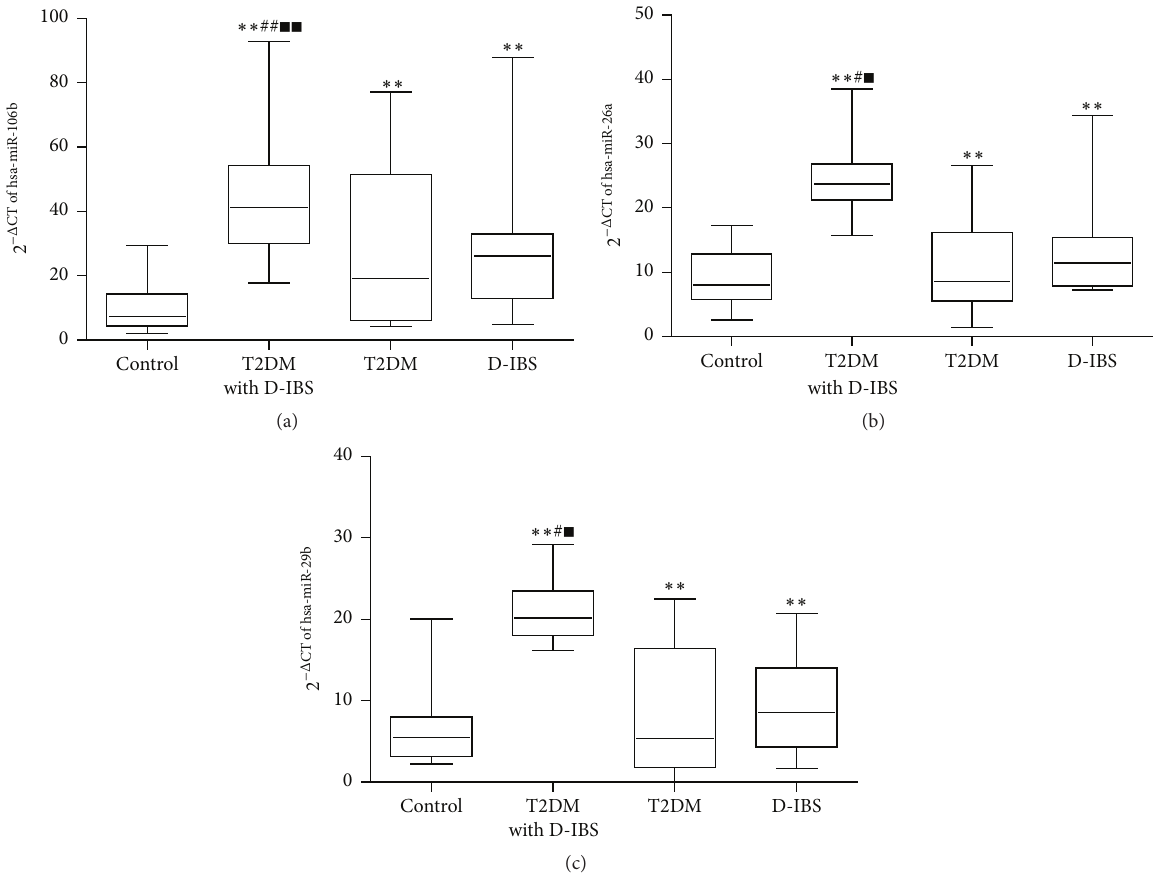
Figure 2: Box plots showing the differential expression of (a) hsa-miR-106b, (b) hsa-miR-26a, and (c) hsa-miR-29b in healthy controls and in patients with T2DM, D-IBS, and T2DM with D-IBS. ∗∗ 𝑝 < 0.01 versus control; ## 𝑝 < 0.01 and # 𝑝 < 0.05 versus T2DM; ◼◼ 𝑝 < 0.01 and ◼ 𝑝 < 0.05 versus